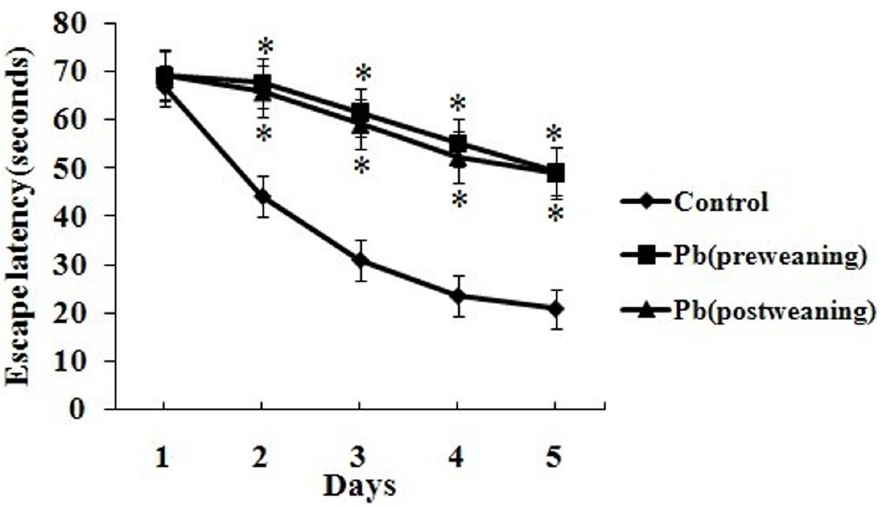
Fig. 4. The mean escapes latency of rat pups with different Pb exposures in the 5-day learning trials of MWM test. Data are expressed as the mean ¡ S.D. of the mean escape latency of 10 animals in each group; p , 0.05, versus control (One-way ANOVA followed by the Bonferroni test).